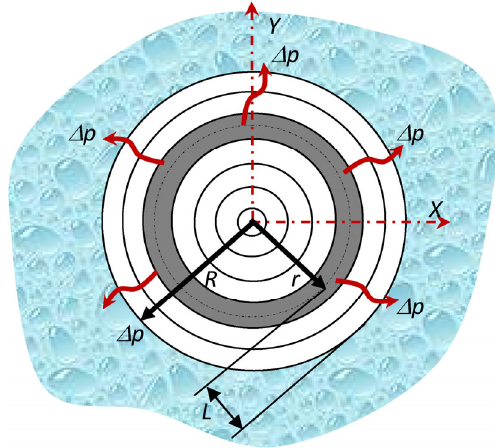
Fig. 13 Pressure loss in cavities due to fluid